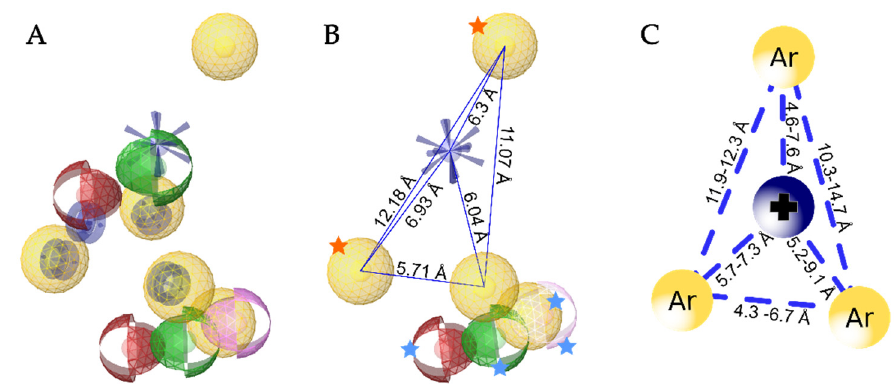
Figure 11. Two-dimensional projections of the frequently appearing pharmacophore models for astemizole ( A ), clofilium ( B ), imipramine ( C ), MK-499 ( D ), and quinidine ( E ) in complex with the homology model of the K V 10.1; these were used in the creation of the final merged pharmacophore model. The pharmacophore features are: hydrophobic features, yellow; aromatic features, blue discs with arrows; hydrogen bond donors, green arrows; hydrogen bond acceptors, red arrows; positive ionizables, blue circles.